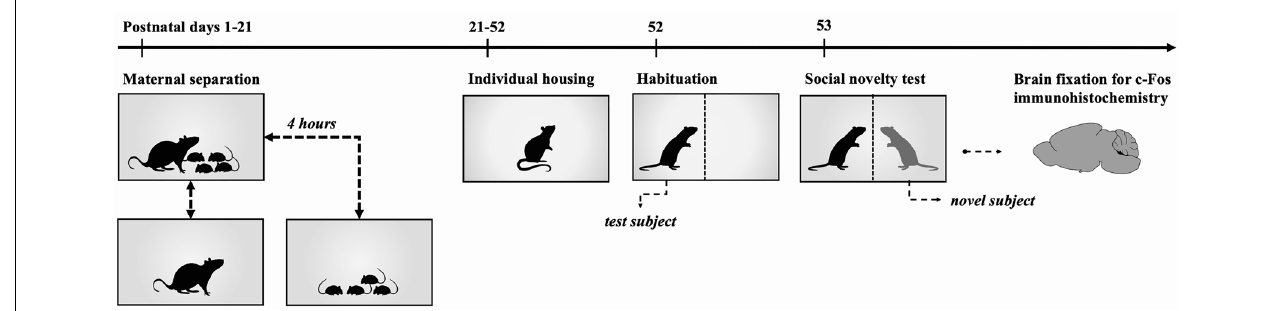
FIGURE 1 | Timeline for Maternal Separation-Social Novelty group. Experimental rats were subjected to 4 h maternal separation from postnatal days 1 to 21. On postnatal day 21 subjects were weaned and housed in individual cages with food and water ad libitum until postnatal day 52. On postnatal day 52, rats were individually placed in the social novelty test area for 30 min to habituate the subjects to the test cage. Following this, individuals were returned to their cages until the following day. Social novelty tests were carried out on postnatal day 53. After social novelty exposure, animals were returned to their respective cages for 1 h and transcardial perfusion was performed for the fixation of the